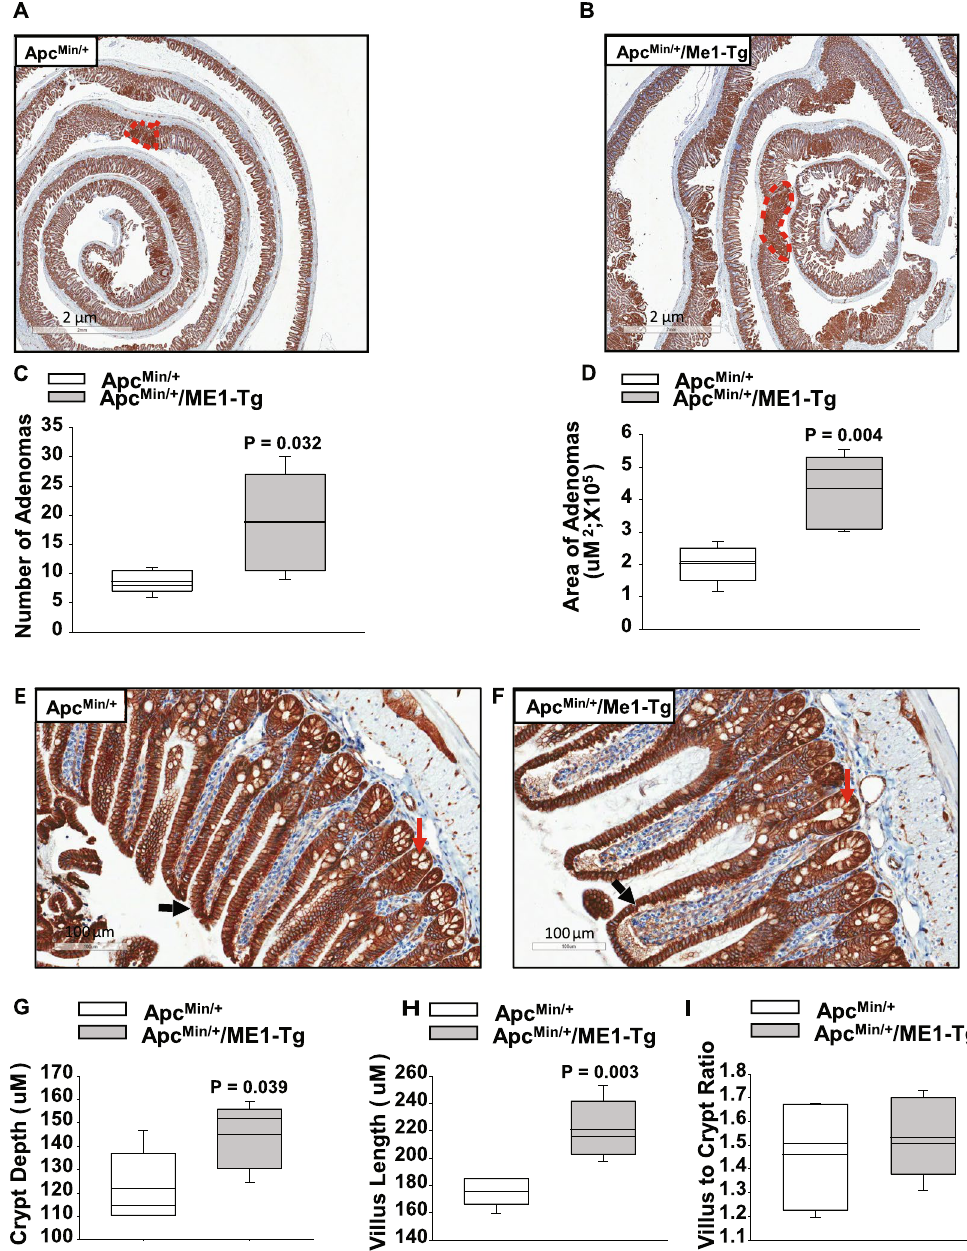
Figure 3. Increased numbers and sizes of ileal adenomas in sixteen-week-old male Apc Min/ + /ME1-Tg mice. ( A , B ) Representative β -catenin IHC of ilea from Apc Min/ + and Apc Min/ + /ME1-Tg male mice (scale bar = 2 μ m). A representative adenoma is outlined in red in each panel. ( C ) Total number of ileal adenomas quantified after β -catenin IHC of male mice (n = 5/group). ( D ) Area of ileal adenomas (total adenoma area per mouse) quantified after β -catenin IHC (n = 5 male mice/group). ( E , F ) Representative images of β -catenin-stained ileum showing normal appearing crypts and villi (scale bar = 100 μ m). Black and red arrows indicate villi and crypts, respectively. ( G ) Quantification of ileal crypt depth in Apc Min/ + and Apc Min/ + /ME1-Tg male mice (n = 5/group). ( H ) Quantification of ileal villus length in male mice (n = 5/group). ( I ) Ratio of villus length to crypt depth in the ilea of male mice (n = 5/group). Boxes indicate the inter-quartile range of 25–75% with mean (thick line) and median (thin line); whiskers extend to the 10 th and 90 th percentiles. Student’s t -tests were used to examine for differences between genotypes (significant difference, P <